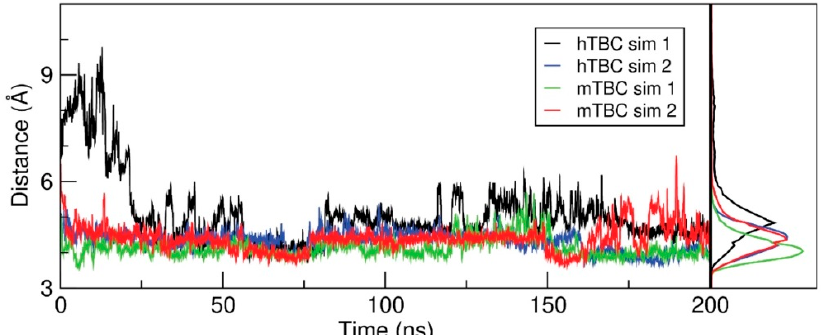
Figure 7. Distance between Ser178 and the C-terminal helix. Left panel: The minimal distance between the C β of Ser178 and the C α of the residues from 304 to 308 is plotted as a function of simulated time, showing how Ser178 is adjacent to the TBC C-terminal helix in most of the snapshots extracted from both human and mouse simulations. Right panel: normalized distributions of the values in the left panel.